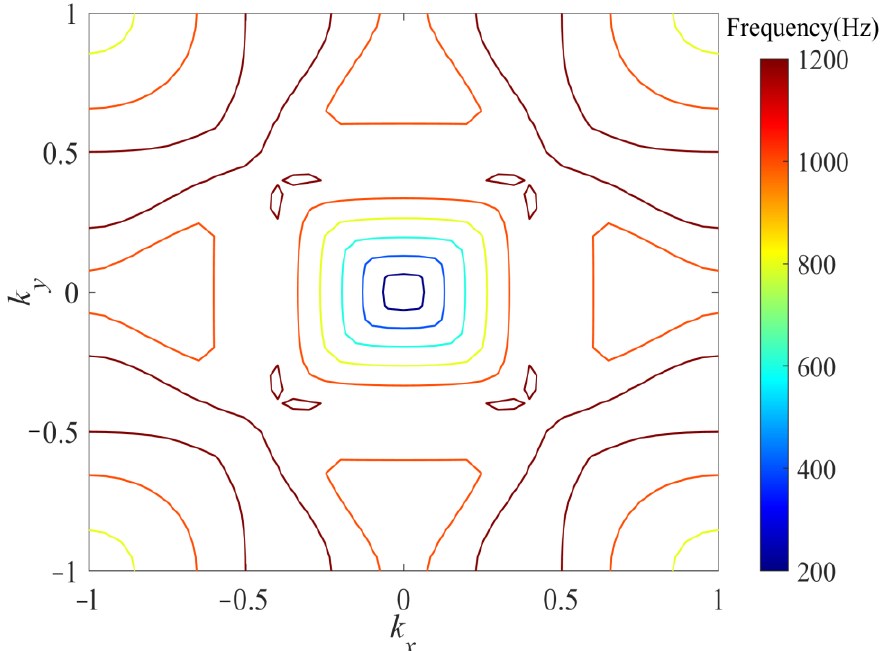
Figure 6. Iso-frequency curves of the proposed piezoelectric phononic crystal.